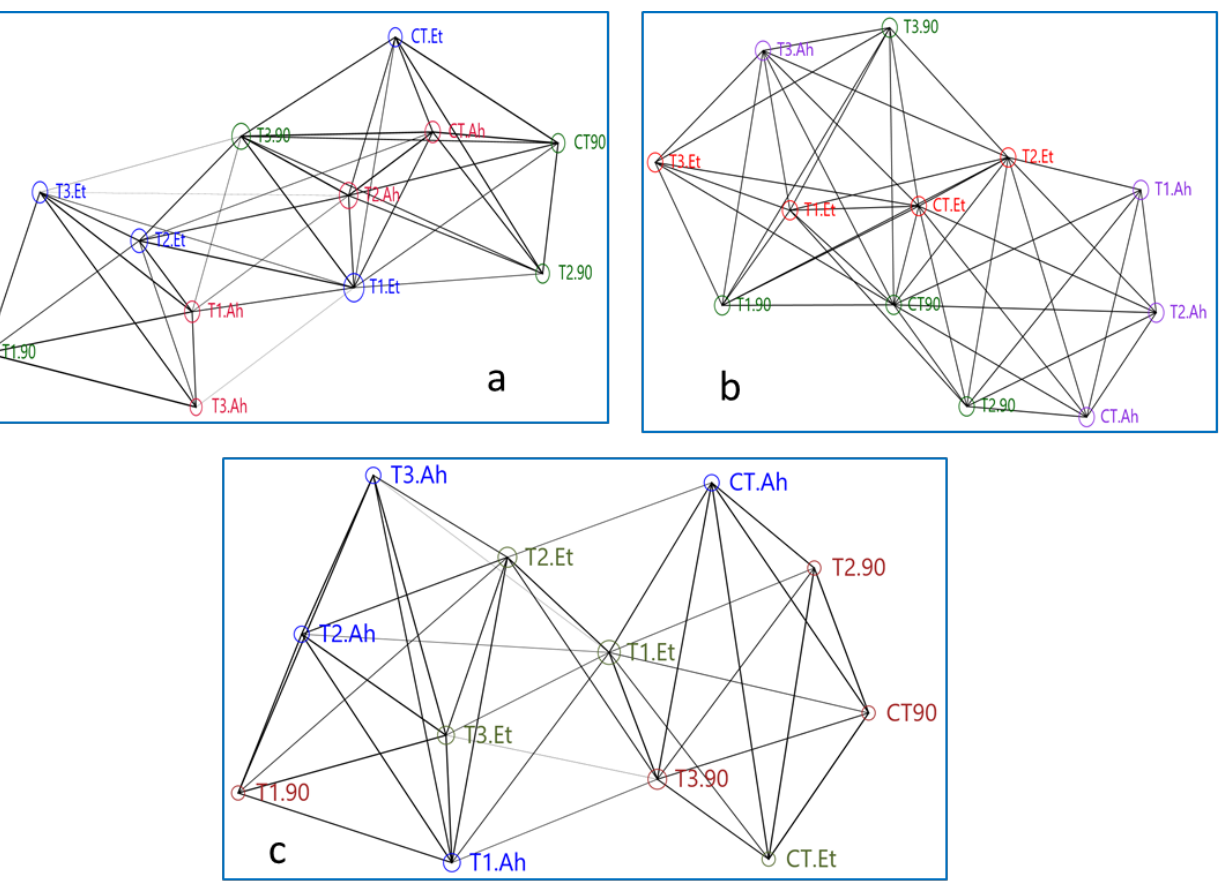
Figure 3. ( a – c ) Showing networking among treatment groups based on genes densiometric parameters. Here, treatment groups followed by a challenge study are being represented as follows: CT, T1, T2, and T3 are the treatment groups, suffix-90 indicates a 90-day feeding trial of these treatment groups, and Et and Ah represent the bacterial isolates Edwardsiella tarda and Aeromonas hydrophila , respectively.